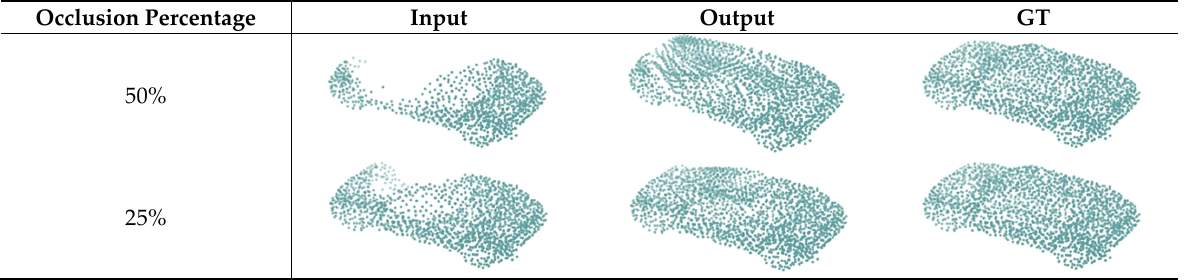
Table 3. The behavior of the network on different categories.